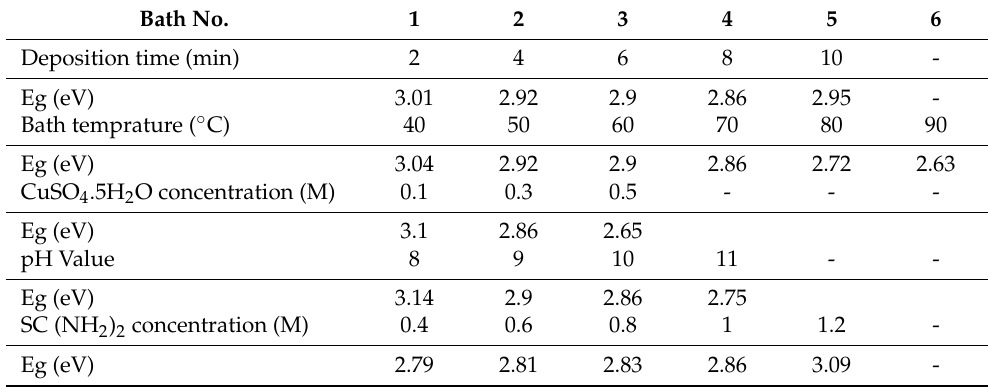
Table 2. Bandgap variation with different deposition parameters. Bath